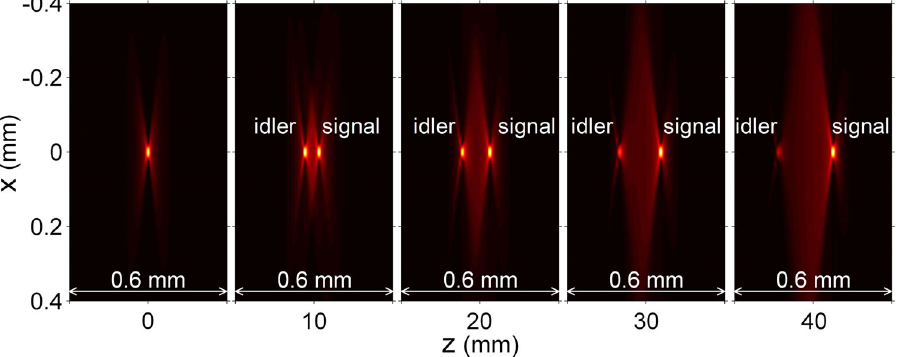
Fig. 5 Double space-time (ST) wave packet propagation in vacuum. Optical parametric ampli fi cation (OPA) is at z = 0, instantaneous ST distributions at z = 0, 10, 20, 30, and 40 mm, containing two ST wave packets of a superluminal signal and a subliminal